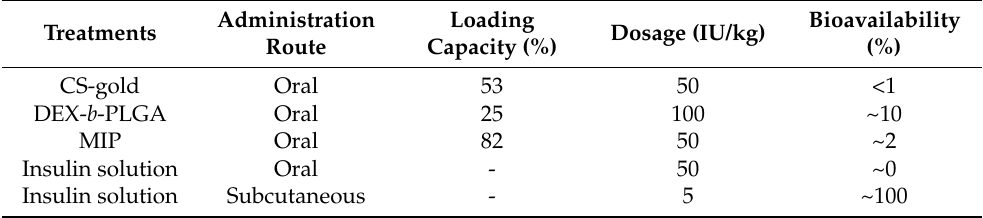
Table 2. Comparison of different insulin treatments [66,101,103]. Treatments